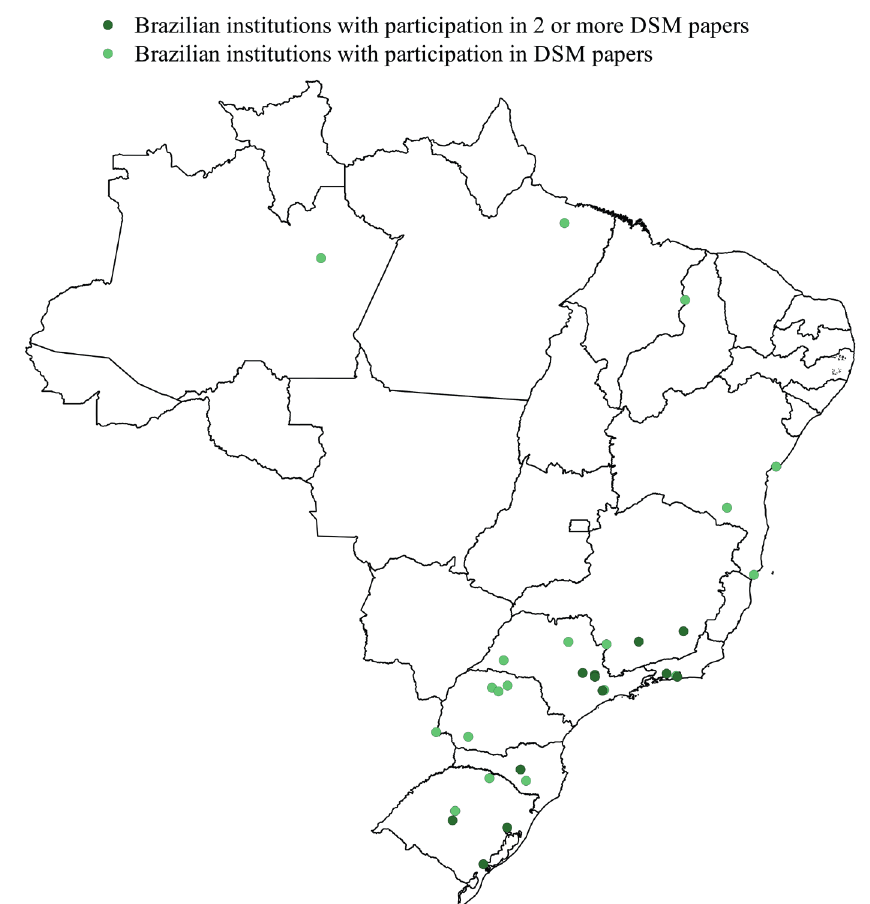
Figure 5 - Brazilian institutions with production of DSM